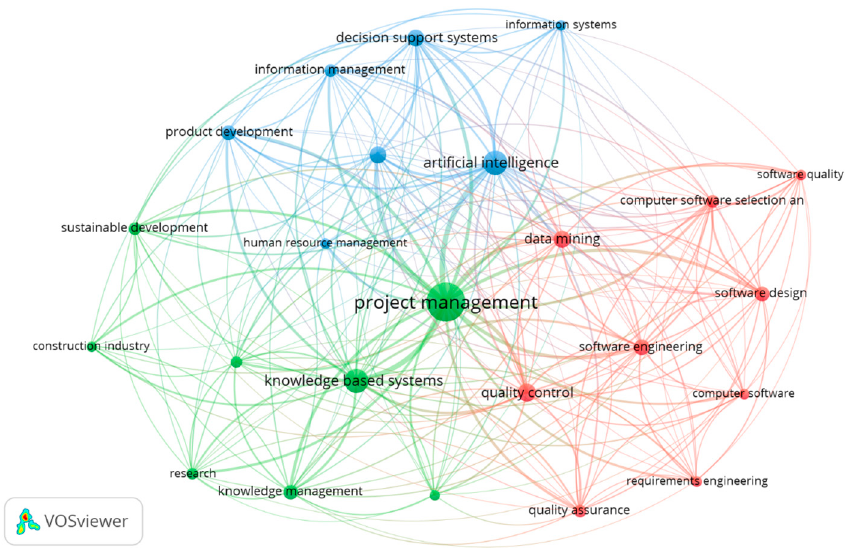
Figure 9. Clusters identified in the Delivery domain.